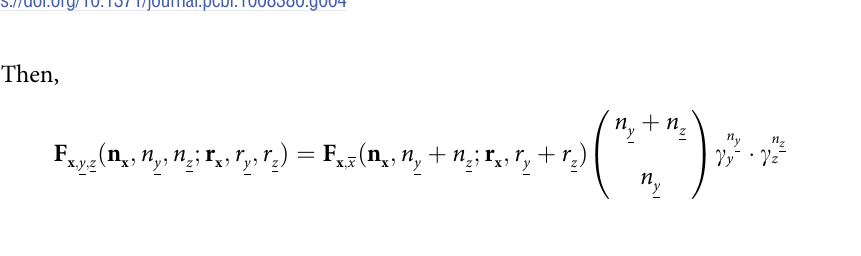
Fig 4. Illustration of Rule 3. Given (a) the partial likelihoods for the x ; x (red) vector of population interfaces, Rule 3 allows us to compute the partial likelihoods for the (green) vector x ; y ; z (b).